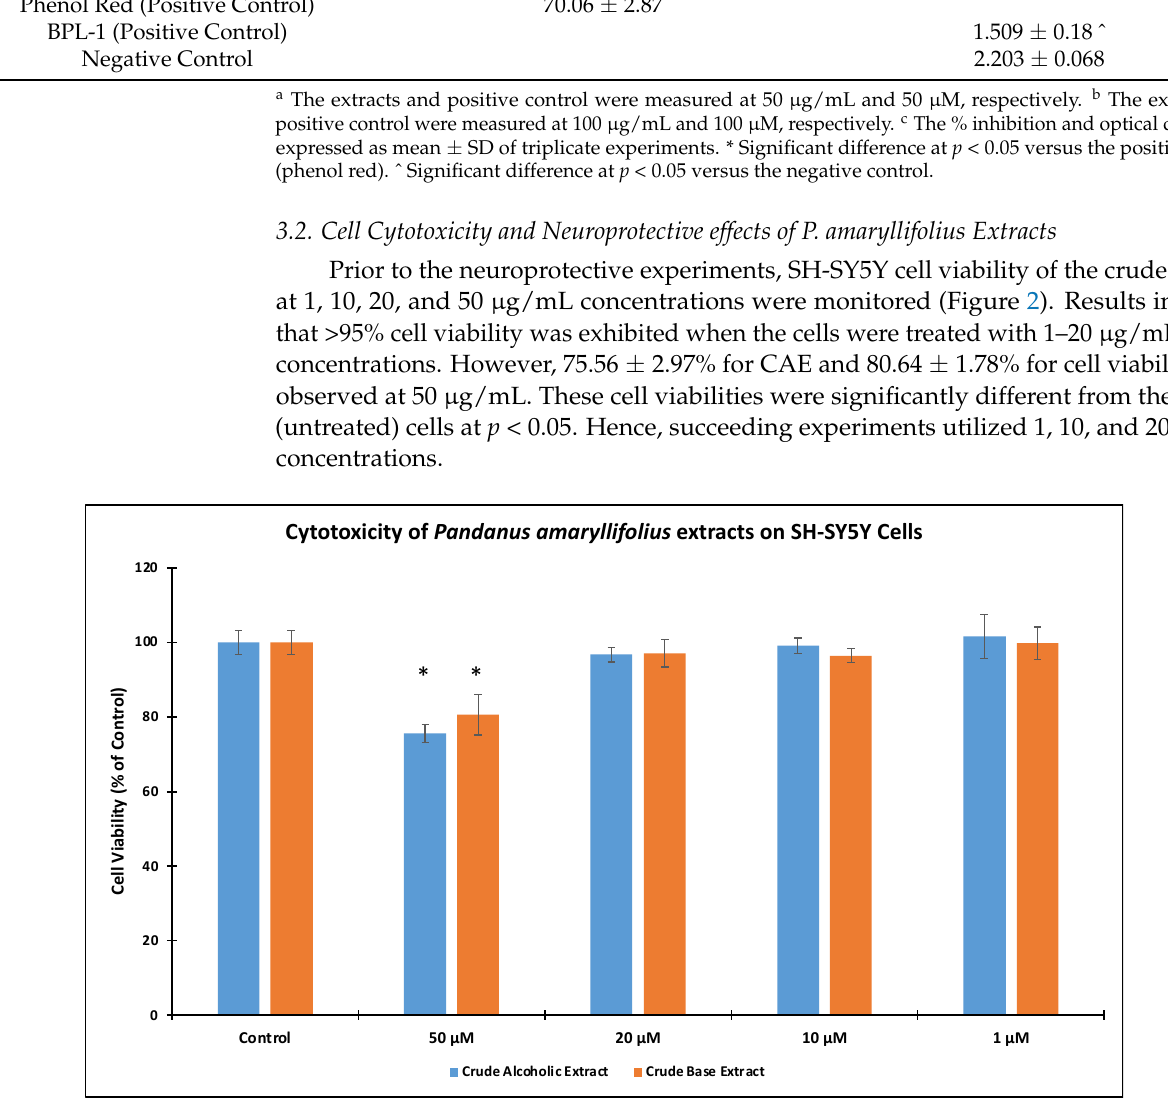
Figure 2. Cell cytotoxicity of Pandanus amaryllifolius Crude Alcoholic Extract (CAE) and Crude Base Extract (CBE). SH-SY5Y cells were treated with 1–50 µ g/mL extract concentration and the cell viability were evaluated by ATP Luminescence assay. “Control” refers to untreated cells. The (*) showed significant difference with the control cells at p <